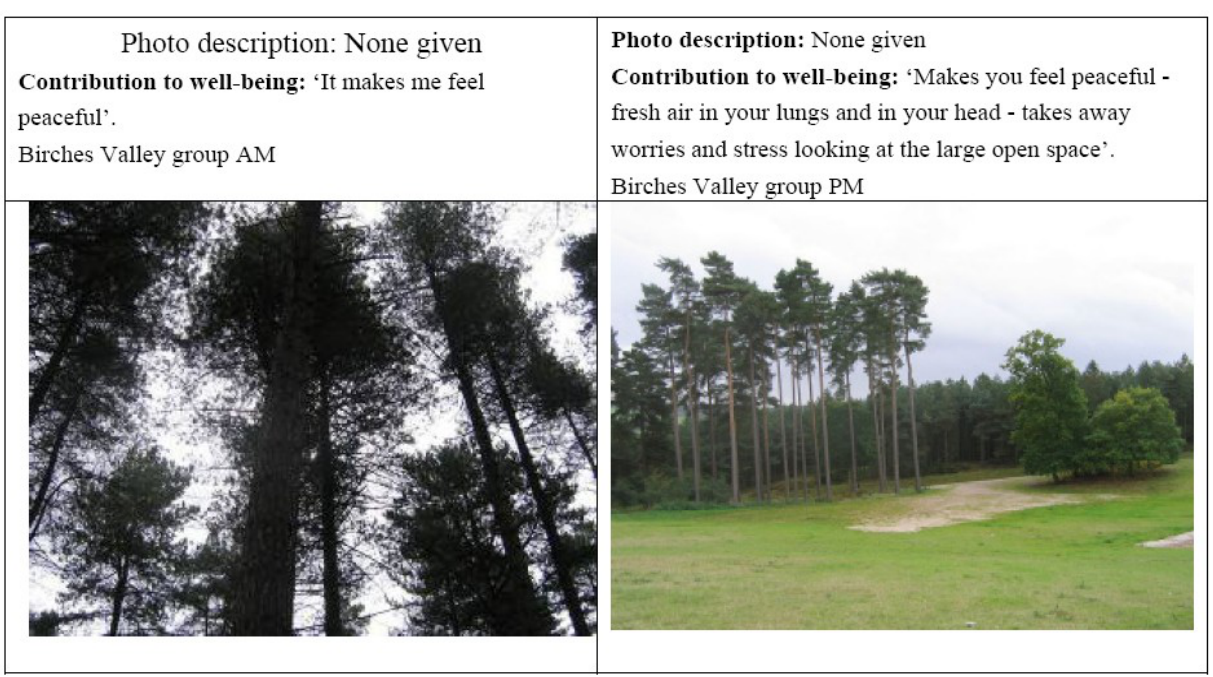
Figure 4. Peacefulness and stress